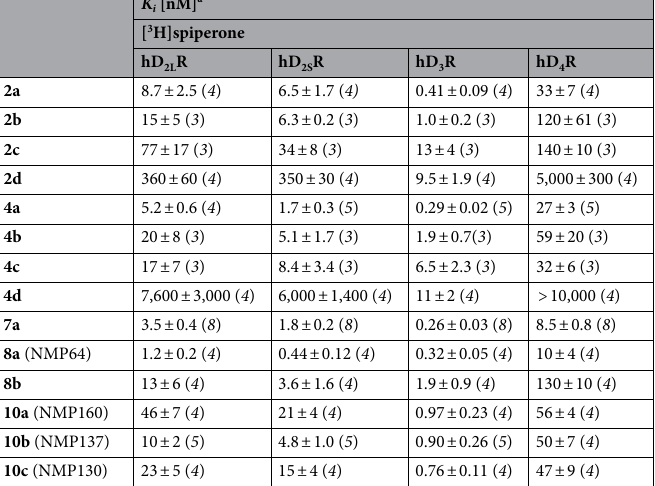
Table 1. Binding affinities of the test compounds. Binding affinities of the test compounds for human D 2L R, D 2S R, D 3 R, D 4 R were determined by radioligand competition. a Data represent mean ± SEM of ( n ) individual experiments, each performed in